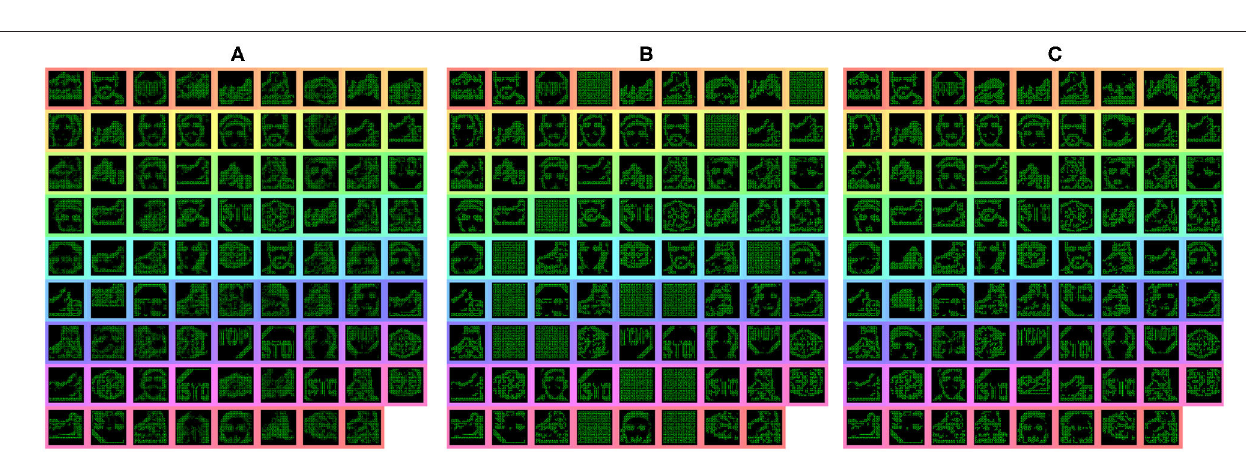
FIGURE 7 | Features from the second convolution layer during training highlighting the pruning process. (A) Highlights the features prior to pruning, (B) shows which feature were reset to initial parameters, and (C) shows the newly learned